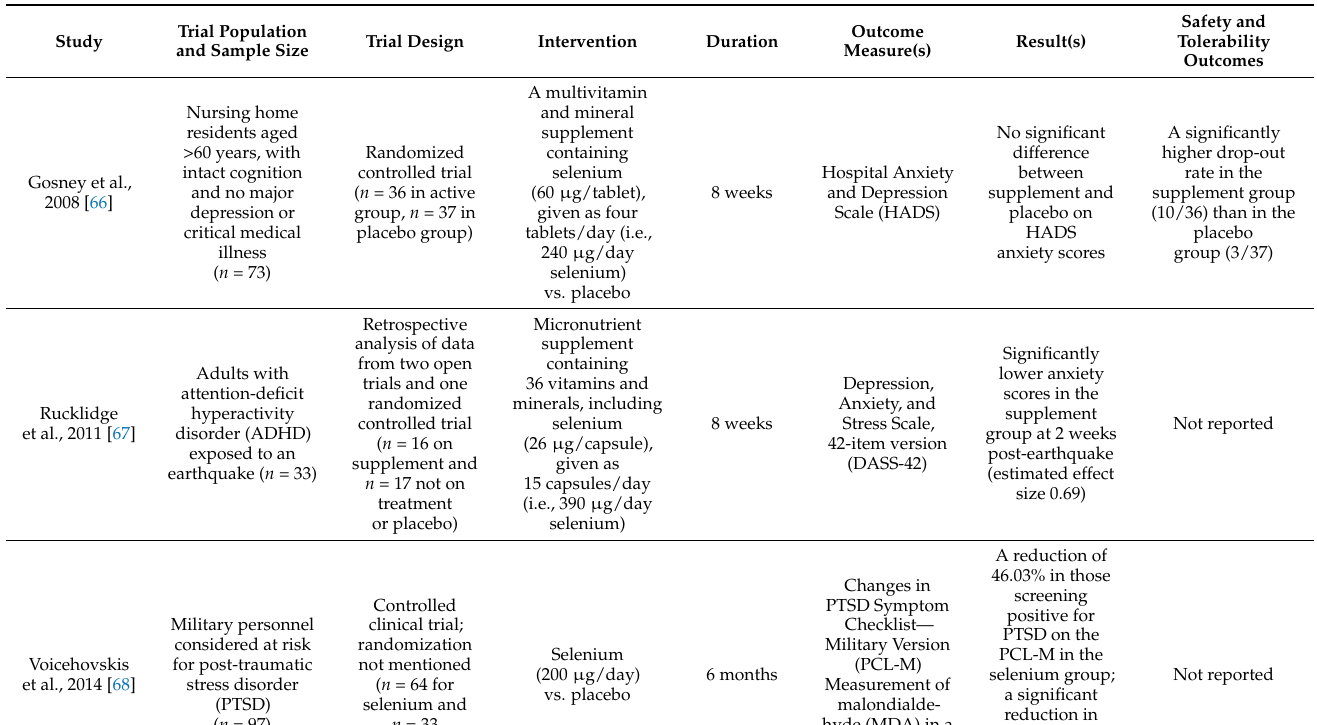
Table 3. Clinical trials of selenium or selenium-containing supplements in patients with anxiety and related disorders or